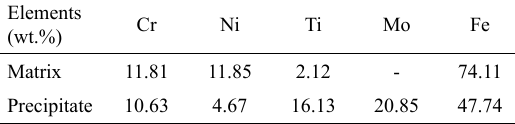
Table 4. Chemical composition of matrix and precipitate of Figure 7.